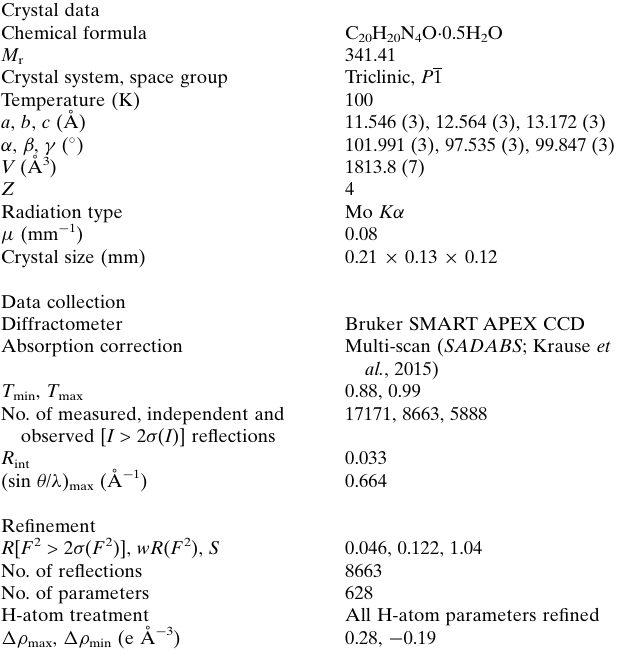
Table 2 Experimental details. Crystal data Chemical